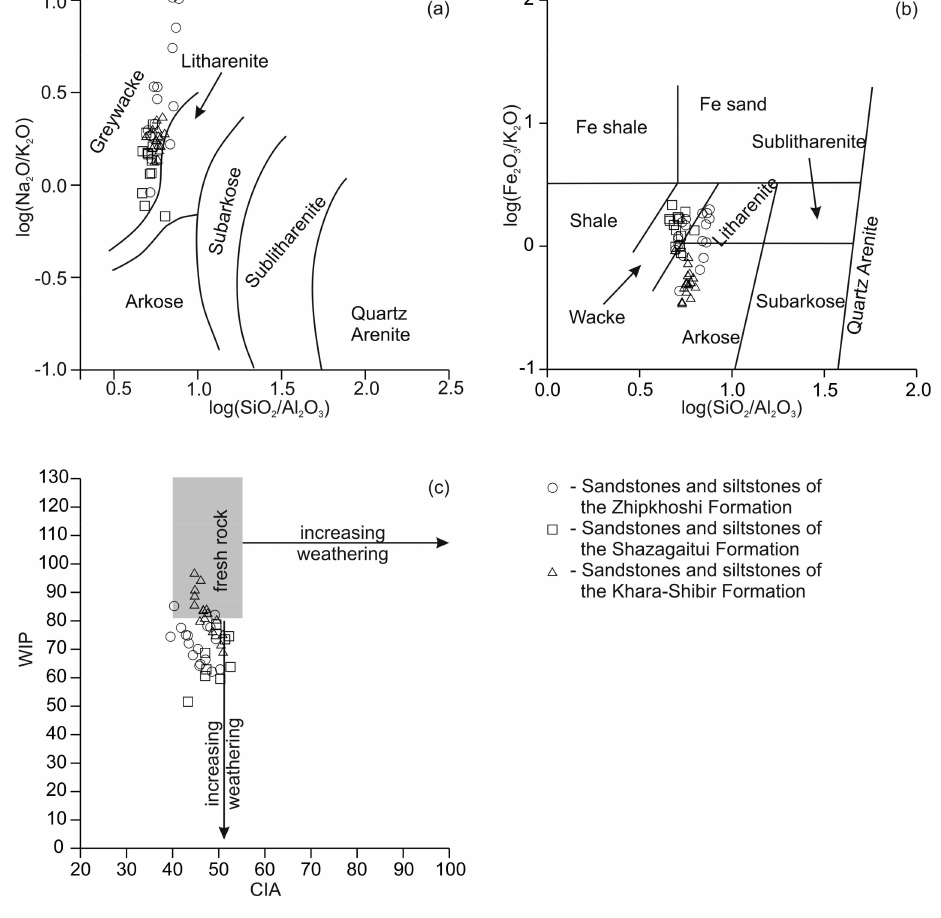
Figure 4. Plots of log(SiO 2 / Al 2 O 3 ) versus log(Na 2 O / K 2 O) after [66] ( a ), log(SiO 2 / Al 2 O 3 ) versus log(Fe 2 O 3 / K 2 O) after [67] ( b ), and CIA versus WIP after [68] ( c ) for siliciclastic rocks of the Chiron